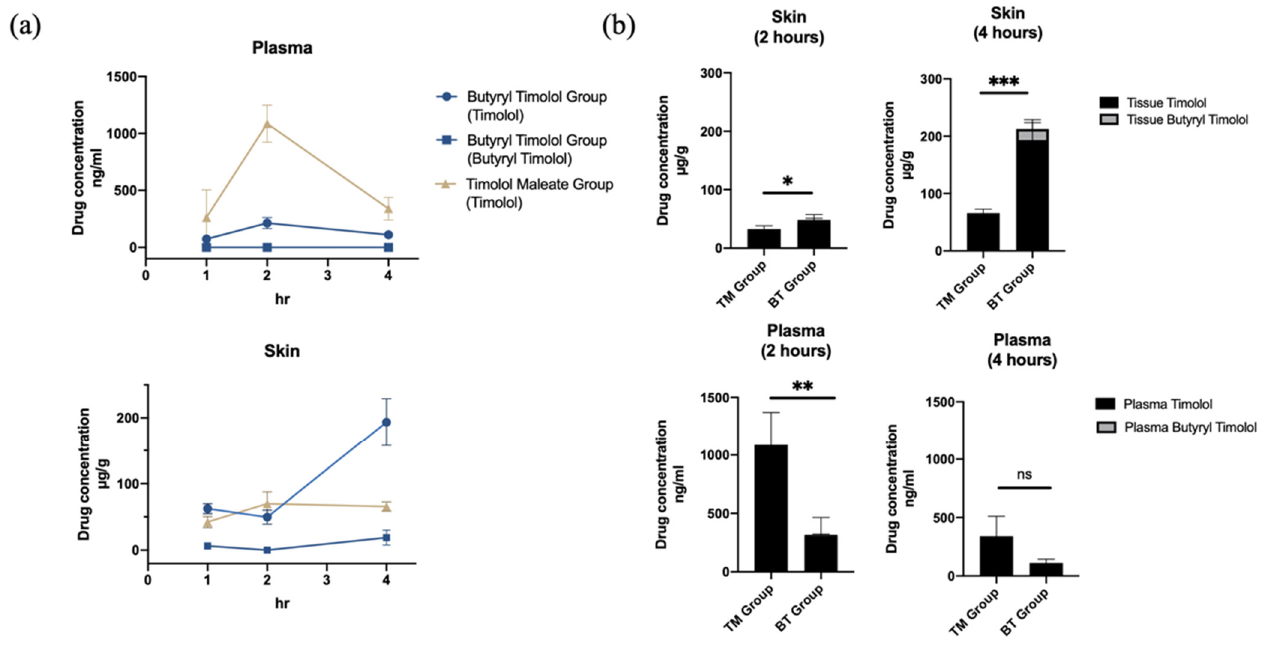
Figure 4. In vivo skin absorption data and plasma concentration of topical TM and BT application. ( a ) Drug concentrations in skin (µg/g) and plasma (ng/mL) over 4 h of TM and BT application. ( b ) Timolol and butyryl timolol levels detected in skin and plasma after 2 and 4 h of topical TM and BT. * p < 0.05; ** p < 0.01; *** p < 0.001; ns, not significant. Table 1. In vivo skin and plasma drug concentrations after topical TM and BT application on SD rat skin. All data are presented as the mean (SD) (n = 3).